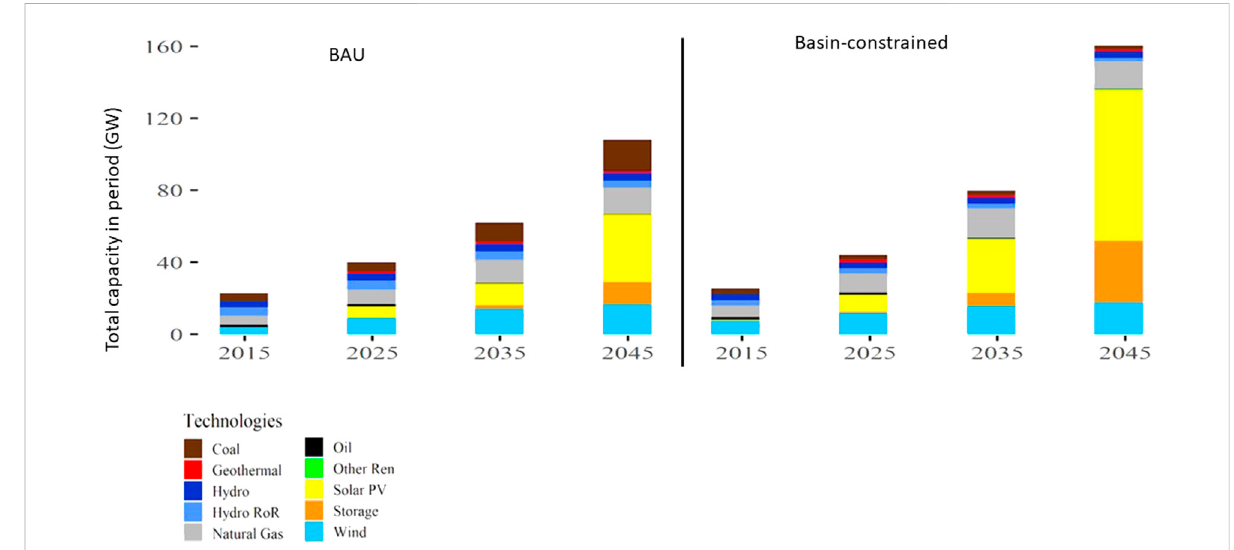
FIGURE 6 Installed capacity for Chile, by period and technology, for reference scenario (BAU) and a scenario that avoided new dams in undeveloped basins (basin-constrained scenario). The river-constrained scenario had a very similar pattern of investment as did the basin-constrained scenario. Figure adapted with permission from Opperman et al.